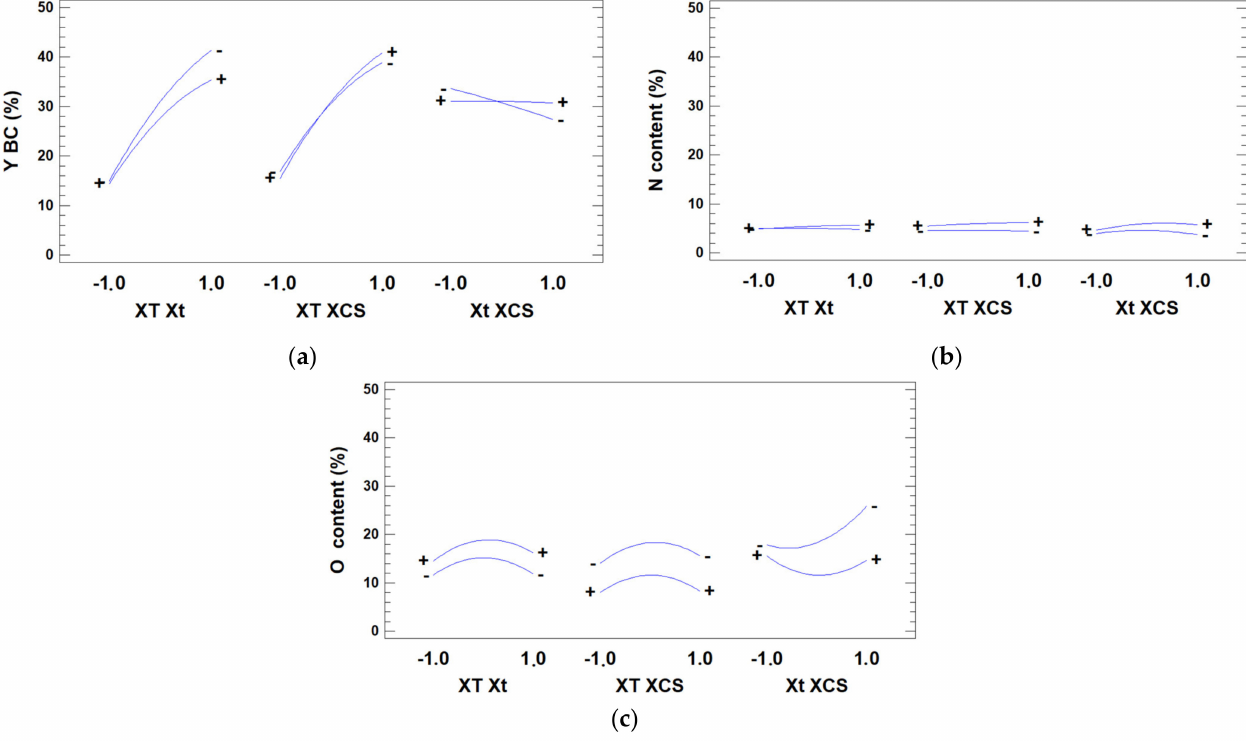
Figure 4. Binary interactions for: ( a ) biocrude yield, ( b ) nitrogen content and ( c ) oxygen